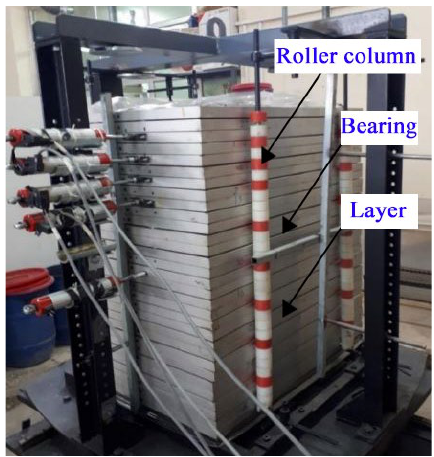
Figure 7. General view of the laminar box (From [28]; modified).